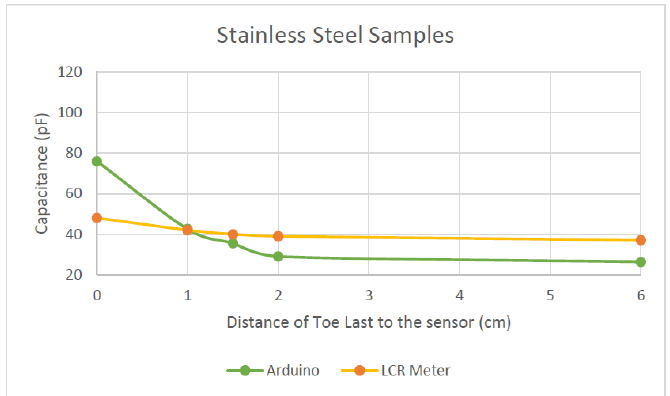
Figure 23. 80/20 polyester/stainless steel sample capacitance reading comparison between Arduino and LCR meter.